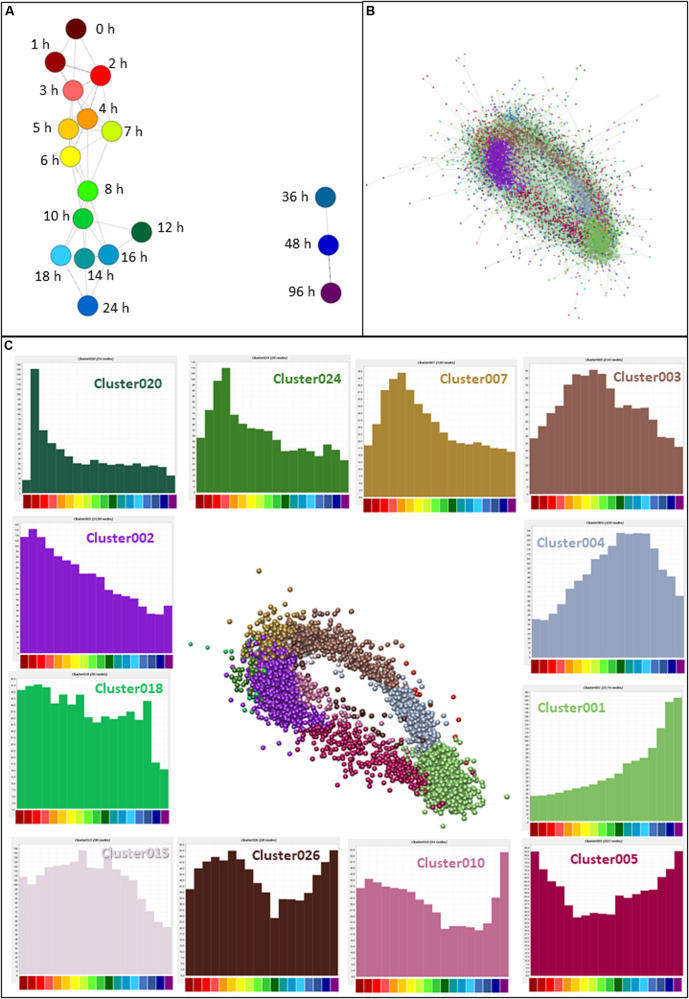
Network analysis of patterns of gene expression throughout differentiation of THP-1 cells. (A) Sample-to-sample analysis. Each node (sphere) represents the average of replicates at a time point, colored as shown in Figure 2D, indicating hours after addition of PMA. Edges between nodes show correlations of ≥0.95. (B) Gene-to-gene analysis showing the main element of the full network. Nodes represent genes (TSS) and the edges between them represent correlations of ≥0.85. MCL clustering was performed at an inflation value of 1.7 and nodes are colored according to their membership in a cluster. (C) Clusters of nodes that are differentially expressed across the time course. Orientation is the same as (B) but edges and other clusters have been removed for ease of visualization. Color of nodes shows the cluster to which nodes were allocated; histograms (colored the same as the nodes in the cluster) show the average expression patterns of the genes within the clusters. Color code for the X axis is as for Figure 2.